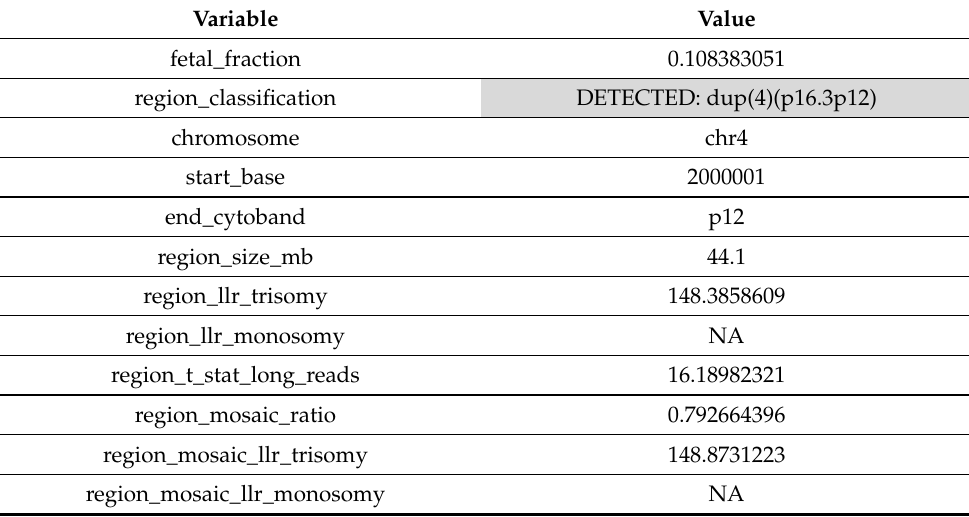
Table 1. NIPT ‘raw data’ indicating a 44.1 duplication of chromosome 4: dup(4)(p16.3p12), in